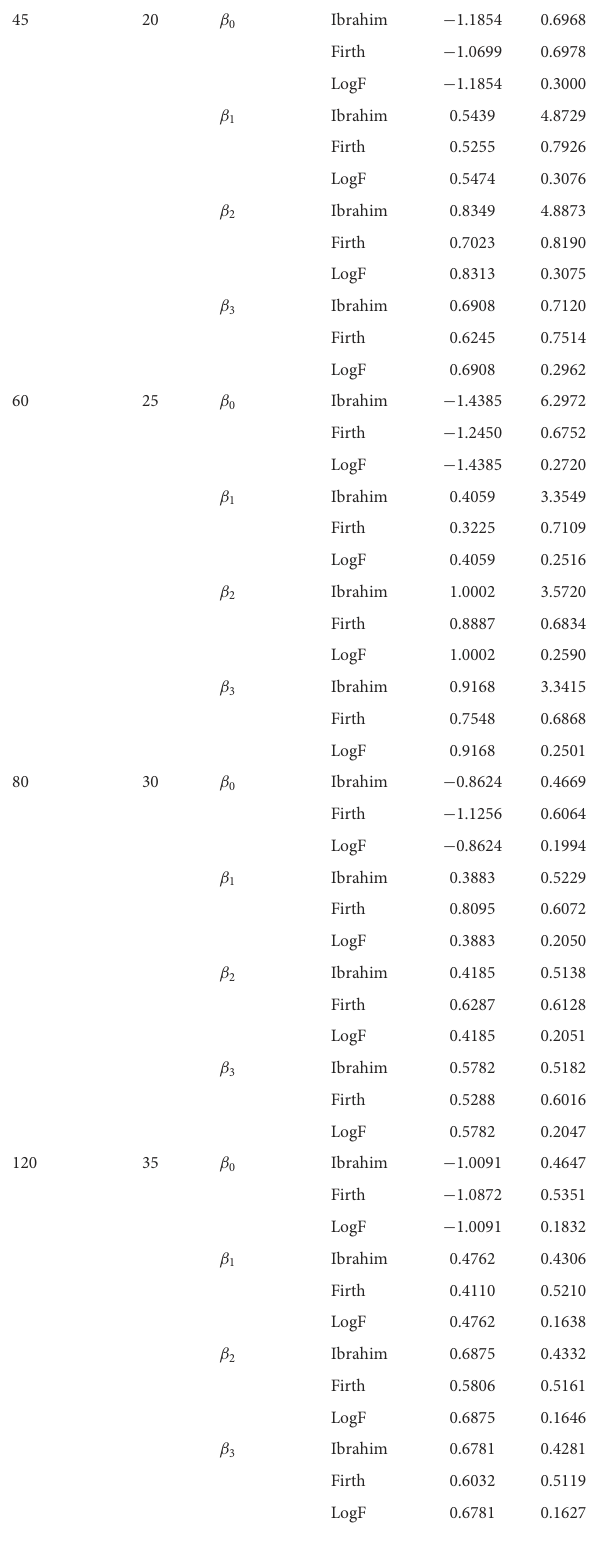
TABLE 1 Validation of the LogF method using standard